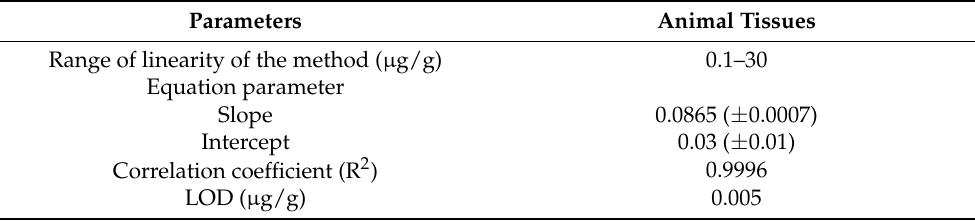
Figure 2. Representative LC-FL chromatograms of blank rat liver plasma extracts ( A ), a liver sample spiked with DOX (5 µg/g) and DAU (IS) at a concentration of 10 µg/g ( B ), after SPE utilizing HLB columns. Table 2. Summary of validation data for the extraction of DOX from rat tissue samples by SPE-LC-FL method ( n =